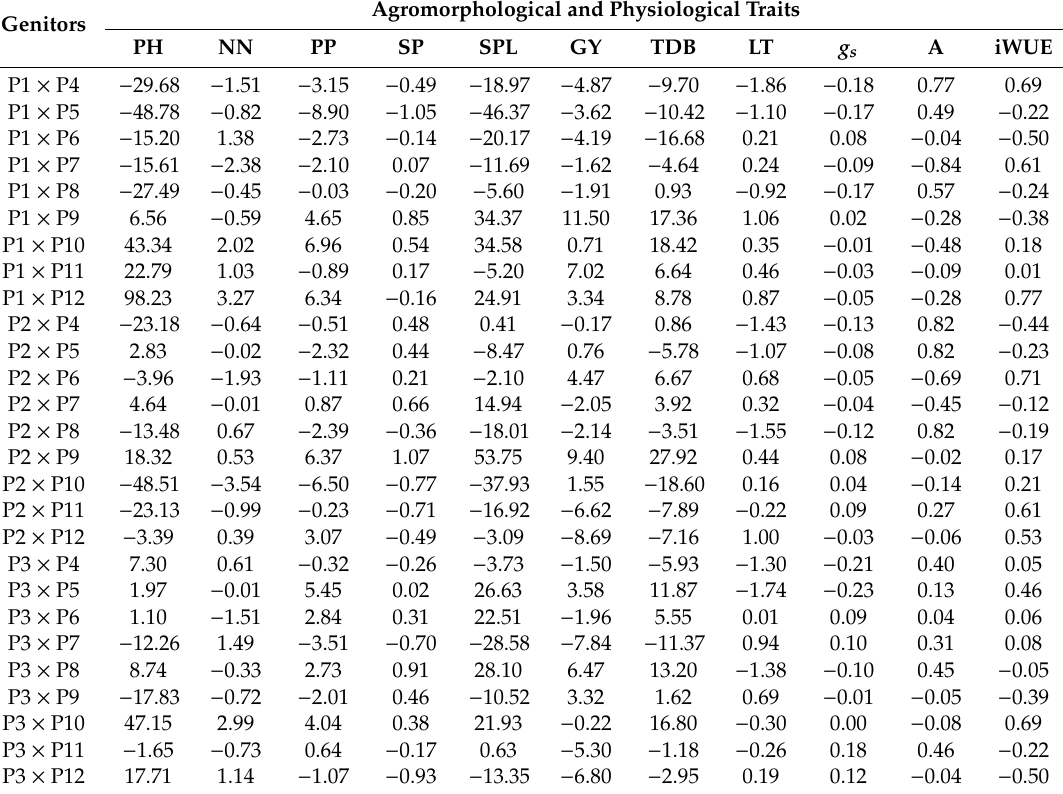
Table 7. Estimates of specific combining ability ( ˆ s ij ) e ff ects resulting from the diallel crosses among the common bean genotypes cultivated under the control condition